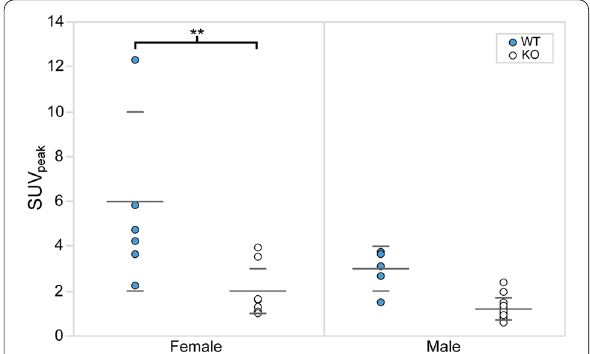
Fig. 4 [ 18 F]FDG SUV peak within interscapular BAT of unfasted female and male mice after NE injection. SUV peak is plotted for each genotype. Means (short) and standard deviations (long) for each group are represented by horizontal gray bars. A statistically significant difference between WT (blue) and KO (white) SUV peak was only observed for female mice ( p 0.002). There was no evidence = that the effect of the genotype depended on the sex of the mouse ( p =